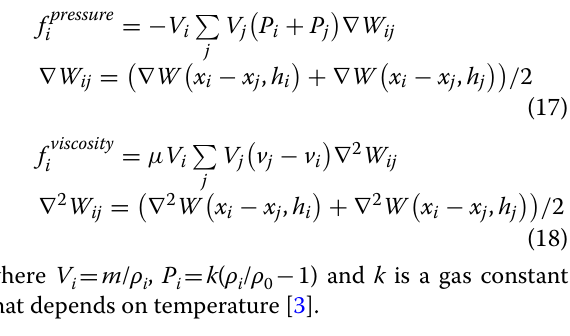
′ i of particle i is computed by